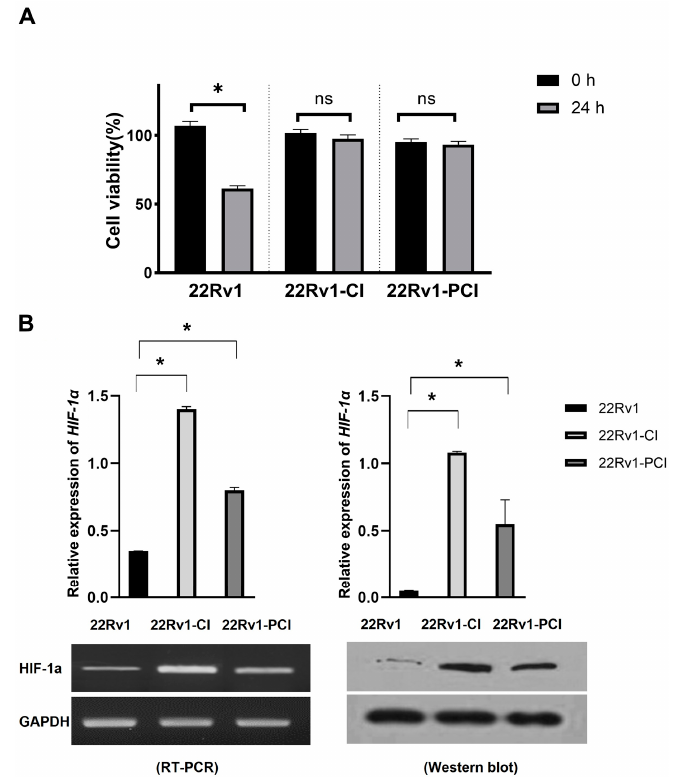
Figure 1. Characterization of hypoxia-resistant cell lines. ( A ) Identification of cell viability in hypoxic environment using MTT assay in 22Rv1 cells or hypoxia-resistant cells (22Rv1-CI and 22Rv1- PCI cell lines). ( B ) mRNA expression and Western blot for HIF-1 α expression in hypoxia-resistant cells (22Rv1-CI and 22Rv1-PCI cell lines) compared with 22Rv1 cells. Data are mean ± SEM. * p < 0.05; ns, not significant.